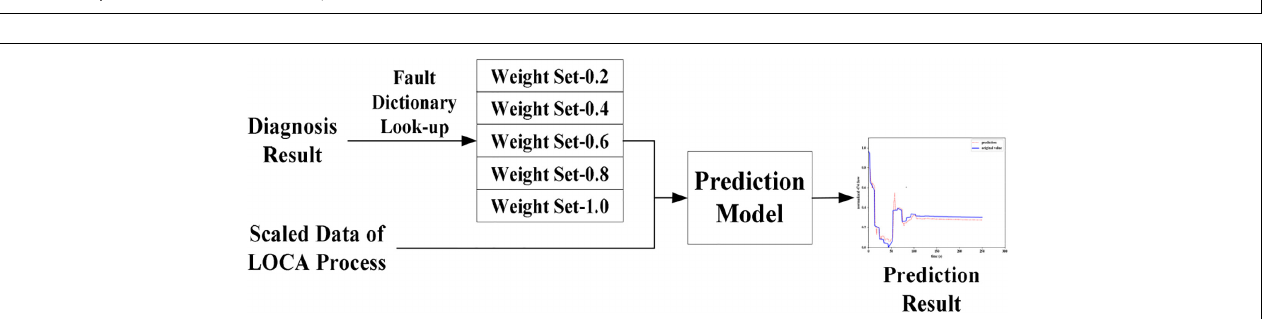
FIGURE 2 | Structure of the Post-LOCA prediction model.